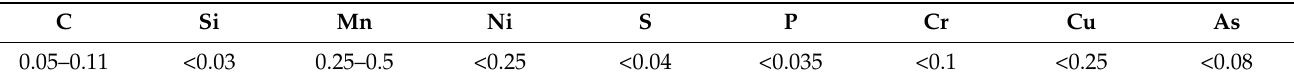
Figure 1. Schematic representation of the cross section of an FCAW wire. Table 1. Chemical composition of 08kp steel, wt %.